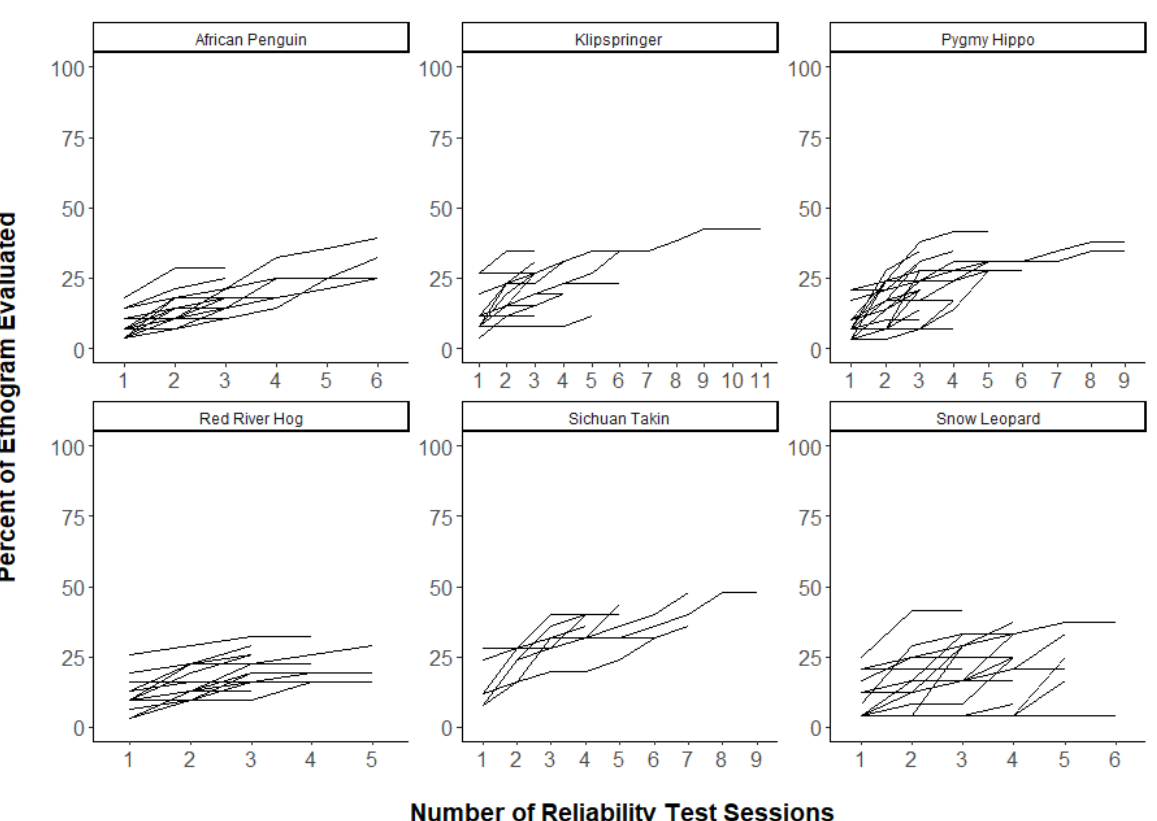
Figure 3. The percent of ethogram behaviors encountered by volunteer observers during successive inter-observer reliability test sessions of six study species monitored as part of a zoo-wide behavior monitoring program. Each line represents data from one volunteer observer. Table 2. The number of reliability test sessions required for observers to “pass 1 ”.